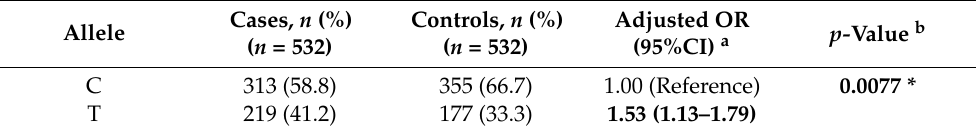
Table 3. Allelic frequencies for H19 rs2839698 polymorphism among childhood leukemia and control